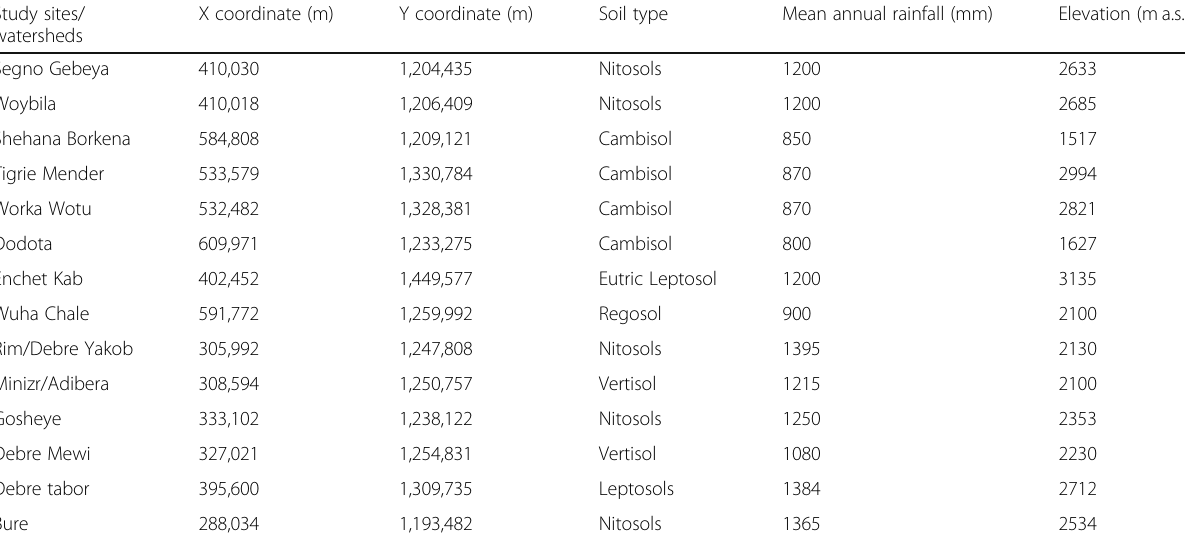
Table 1 Study sites geographical location, soil type, rainfall and elevation Study sites/